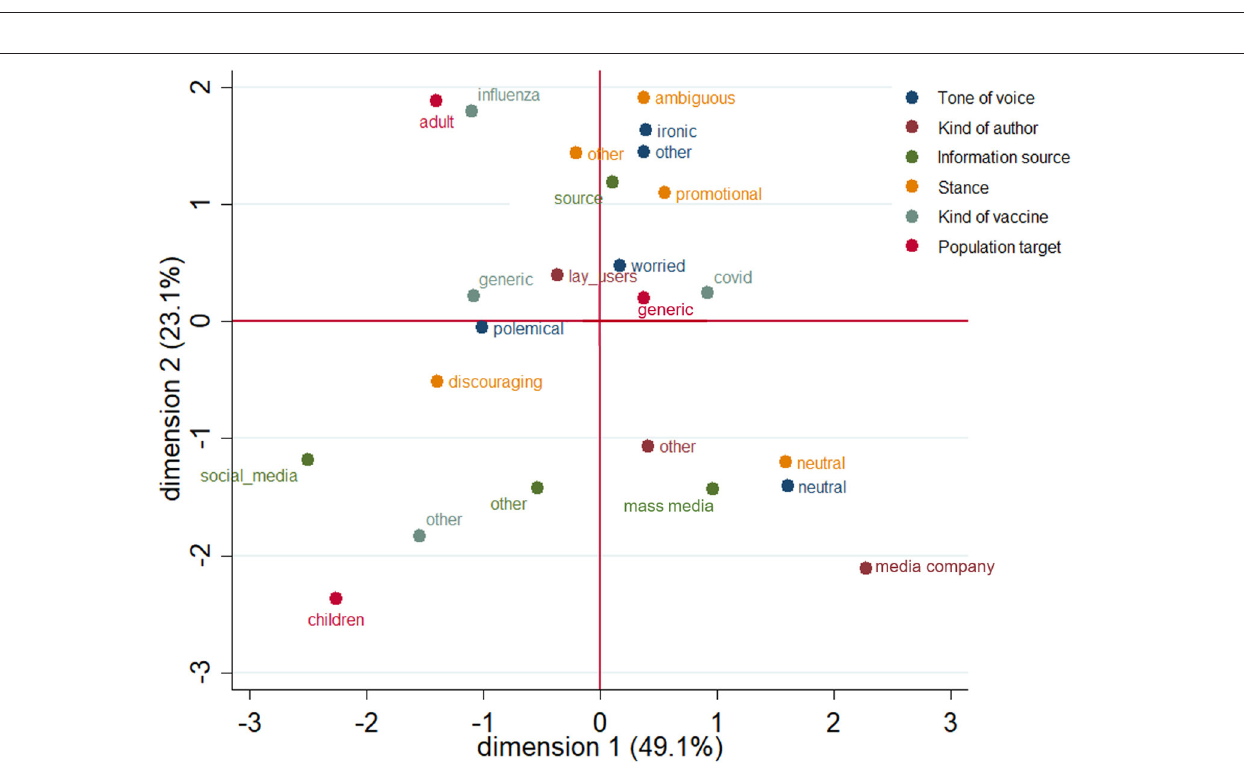
FIGURE 4 | Multiple corresponding